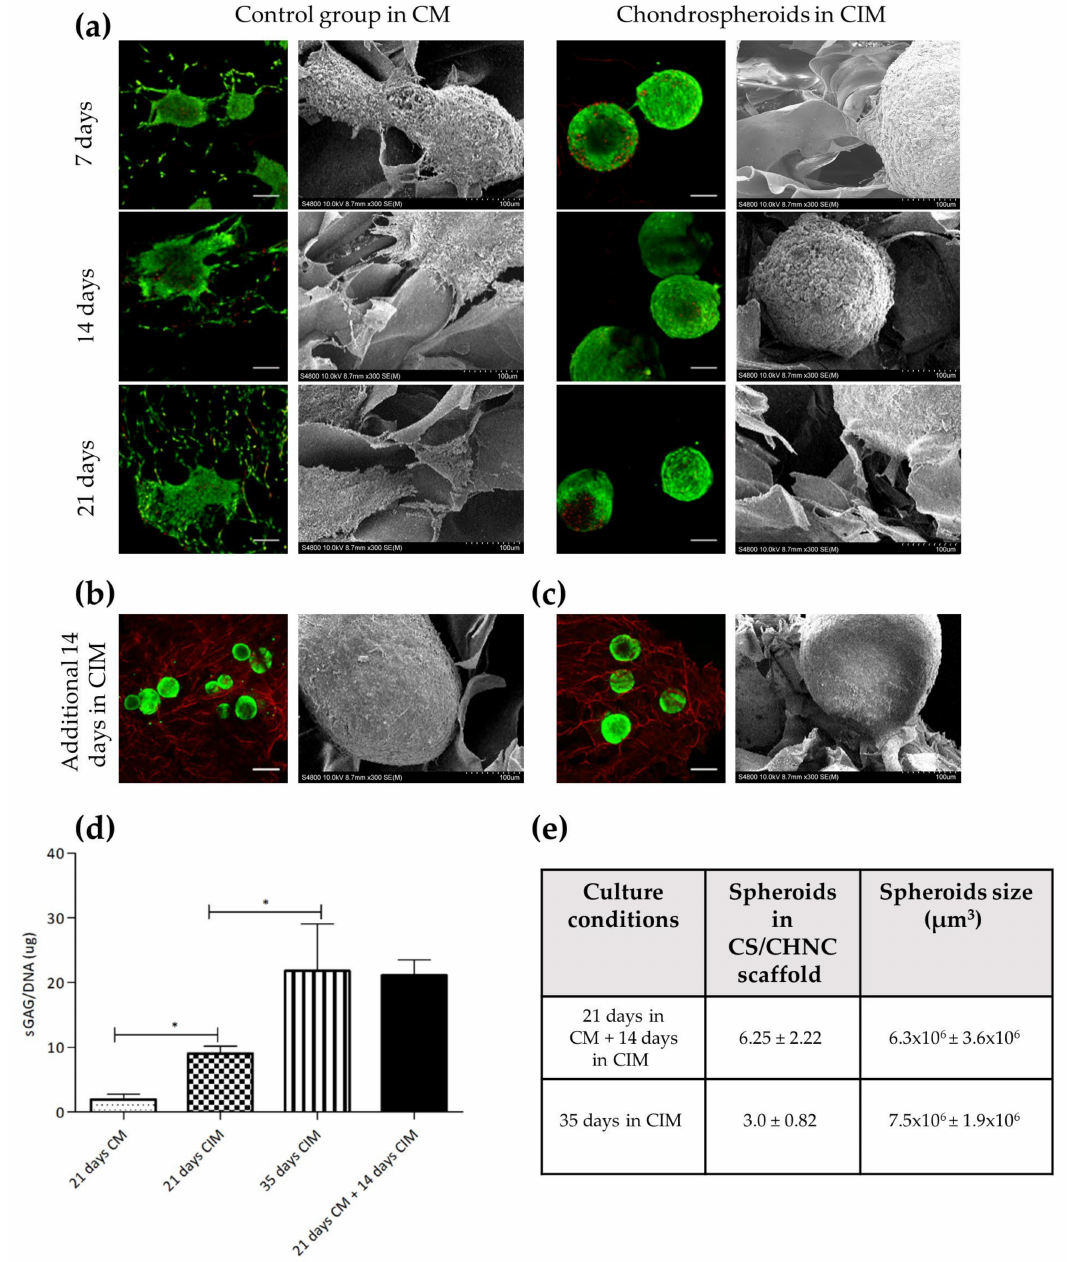
Figure 5. Establishment of the cartilage tissue engineering (TE) construct based on hASC spheroids adhered to the 3D porous CS / CHNC sca ff old in hypoxic conditions. Viability (Live / Dead assay) and adhesion (SEM) of the ( a ) control group spheroids and chondrospheroids at 7, 14 and 21 days, ( b ) hASC spheroids cultured at 21 days in CM plus an additional 14 days in CIM and ( c ) hASC spheroids cultured for 35 in CIM. ( d ) Quantification of the ECM deposition, in terms of sGAG / DNA ( µ g), from spheroids cultured 21 days in CM, 21 days in CIM, 21 days in CM plus an additional 14 days in CIM and 35 days in CIM. ( e ) Number of spheroids distributed through the sca ff old and spheroid size. The scale bar represents ( a ) 200 µ m and ( b ) 500 µ m in the fluorescence images × 300 magnification in the SEM images. Three constructs containing 20 spheroids for each time and condition were used. Data shown are mean ± SD (* p < 0.05; one-way